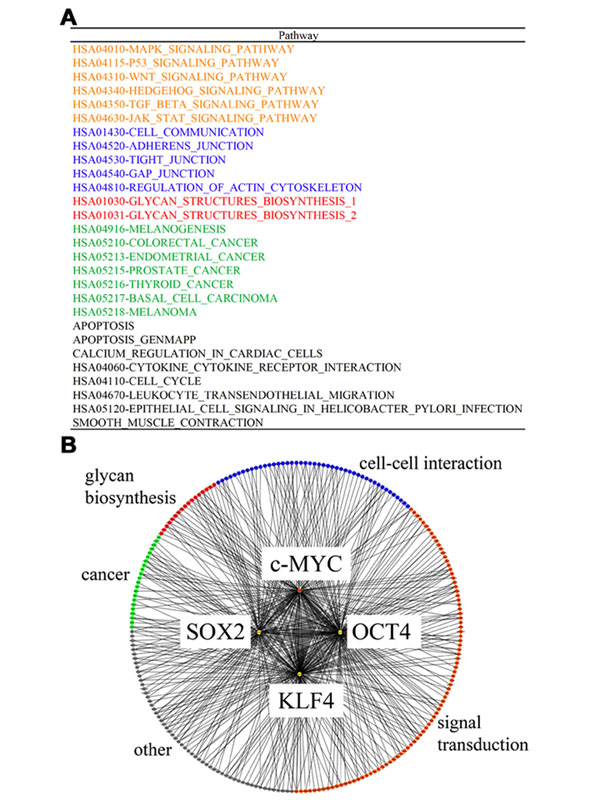
Network signature (A) List of network signatures. The pathways with significant probabilities are classified into the following categories: orange, pathways related to signal transduction; blue, pathways related to cell-cell interactions; red, pathways related to glycan biosynthesis; green, pathways related to cancer; and black, unclassified pathways. (B) Schematic presentation of networks. The four induced factors are described in the center, and the binding genes, which are colored according to the classification scheme described in (A), are connected by thin lines.